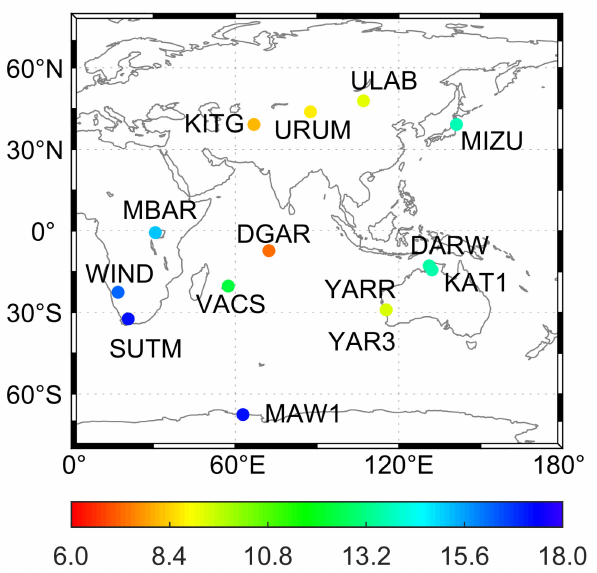
Figure 11. Station-dependent RMS statistics of 3D positioning errors for IRNSS-only SPP at 14 MGEX stations on 7–13 July 2019 (unit: